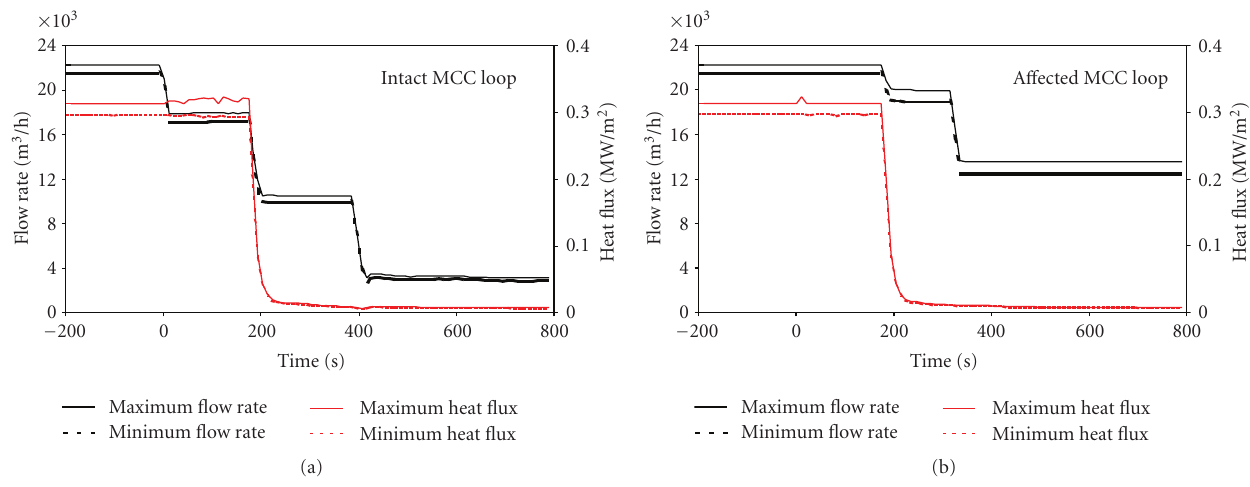
Figure 14: Three MCPs sequential trip. Comparison of behaviour of coolant flow rate through one MCC loop and heat flux in average loaded fuel channel. Table 2: Parameters which may impact the uncertainty of calculation results in sequential MCPs trip case.